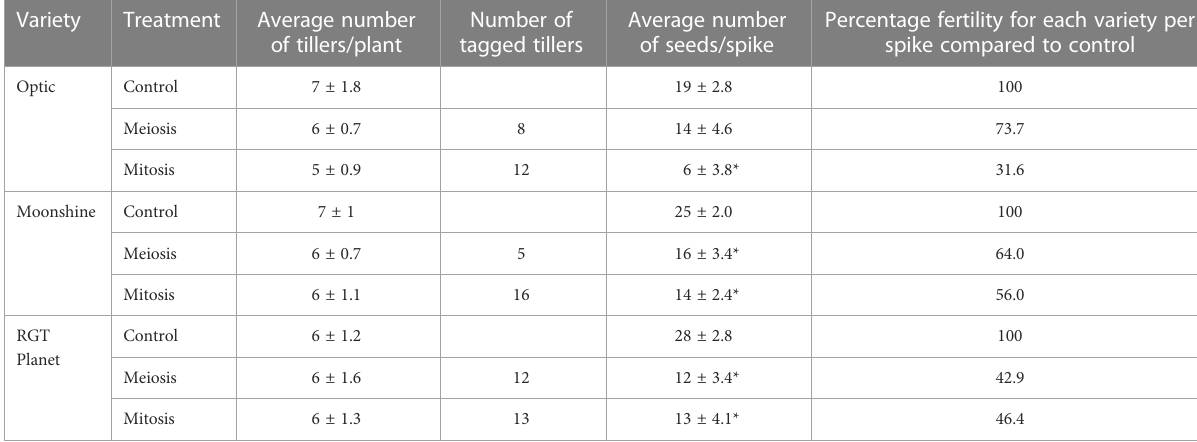
TABLE 1 Average number of tillers per plant and seeds per spike, and number of tagged tillers for the three different varieties in control conditions, after PMC meiosis heat treatment or after pollen mitosis heat treatment ± standard deviation. Variety